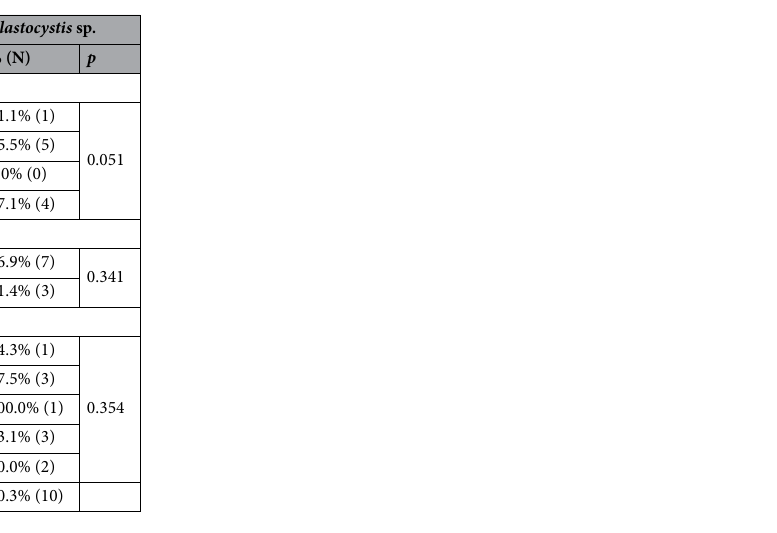
Table 4. The demographics and the prevalence of Blastocystis sp. in the cat owners of Tehran, Iran.